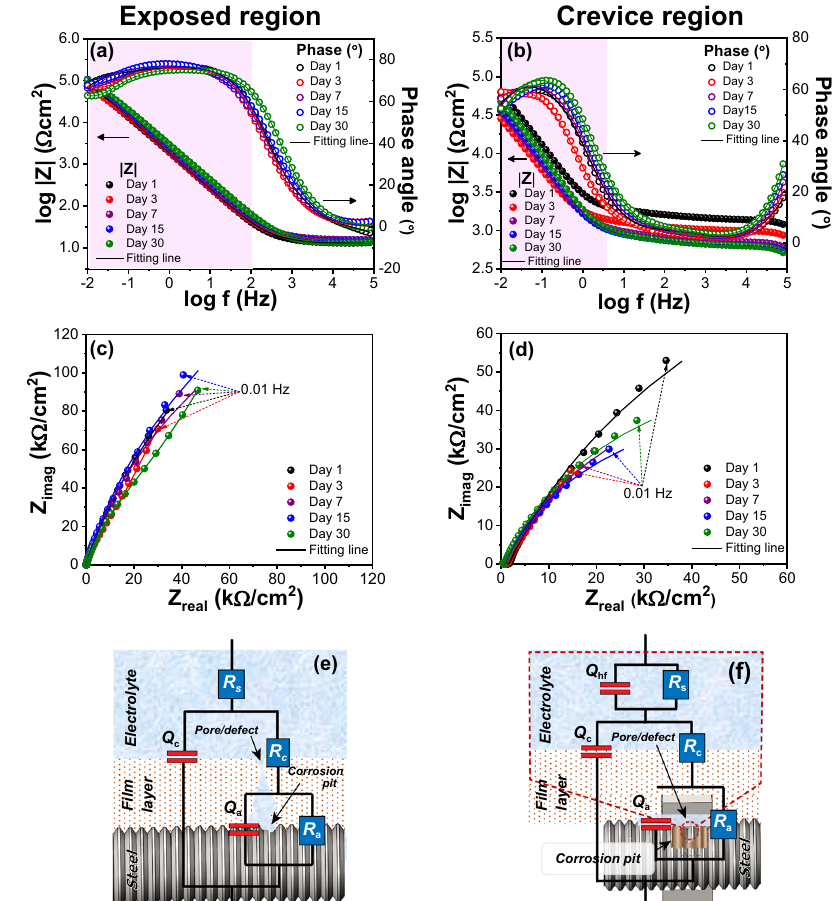
Fig. 8 EIS data for the exposed and crevice samples, respectively. a , b Bode plots, c , d Nyquist plots, e , f equivalent electrical circuits (EEC) for modelling the corrosion in the different exposed systems, respectively. In these circuits, R s represents the solution resistance, R c and R a represent the cathodic and anodic polarization resistances, Q c denotes the constant phase element (CPE) of the passive fi lm, and Q a is the CPE of the electric double layer. Q hf represents the CPE for fi tting the high-frequency phase